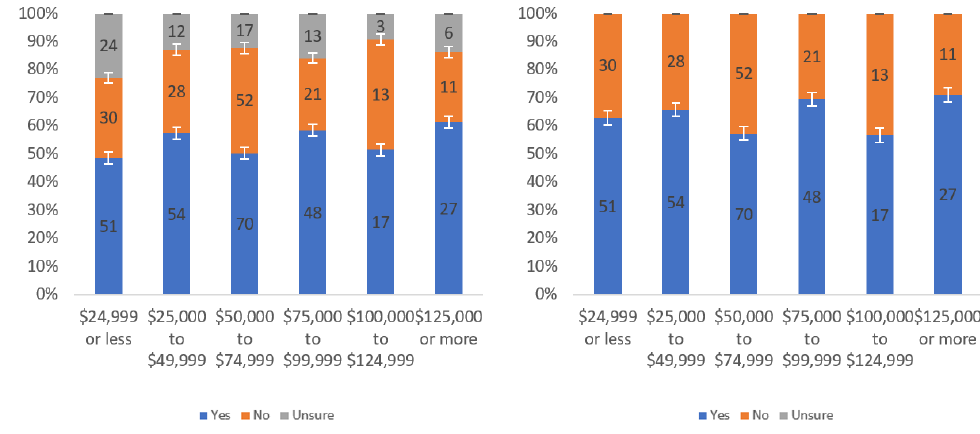
Figure 51. Responses regarding usefulness in judging trustworthiness by income level including ( left ) and excluding ( right ) unsure responses.